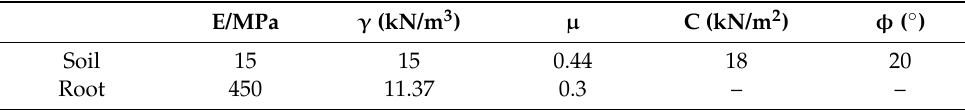
Table 2. Properties of the soils and roots.